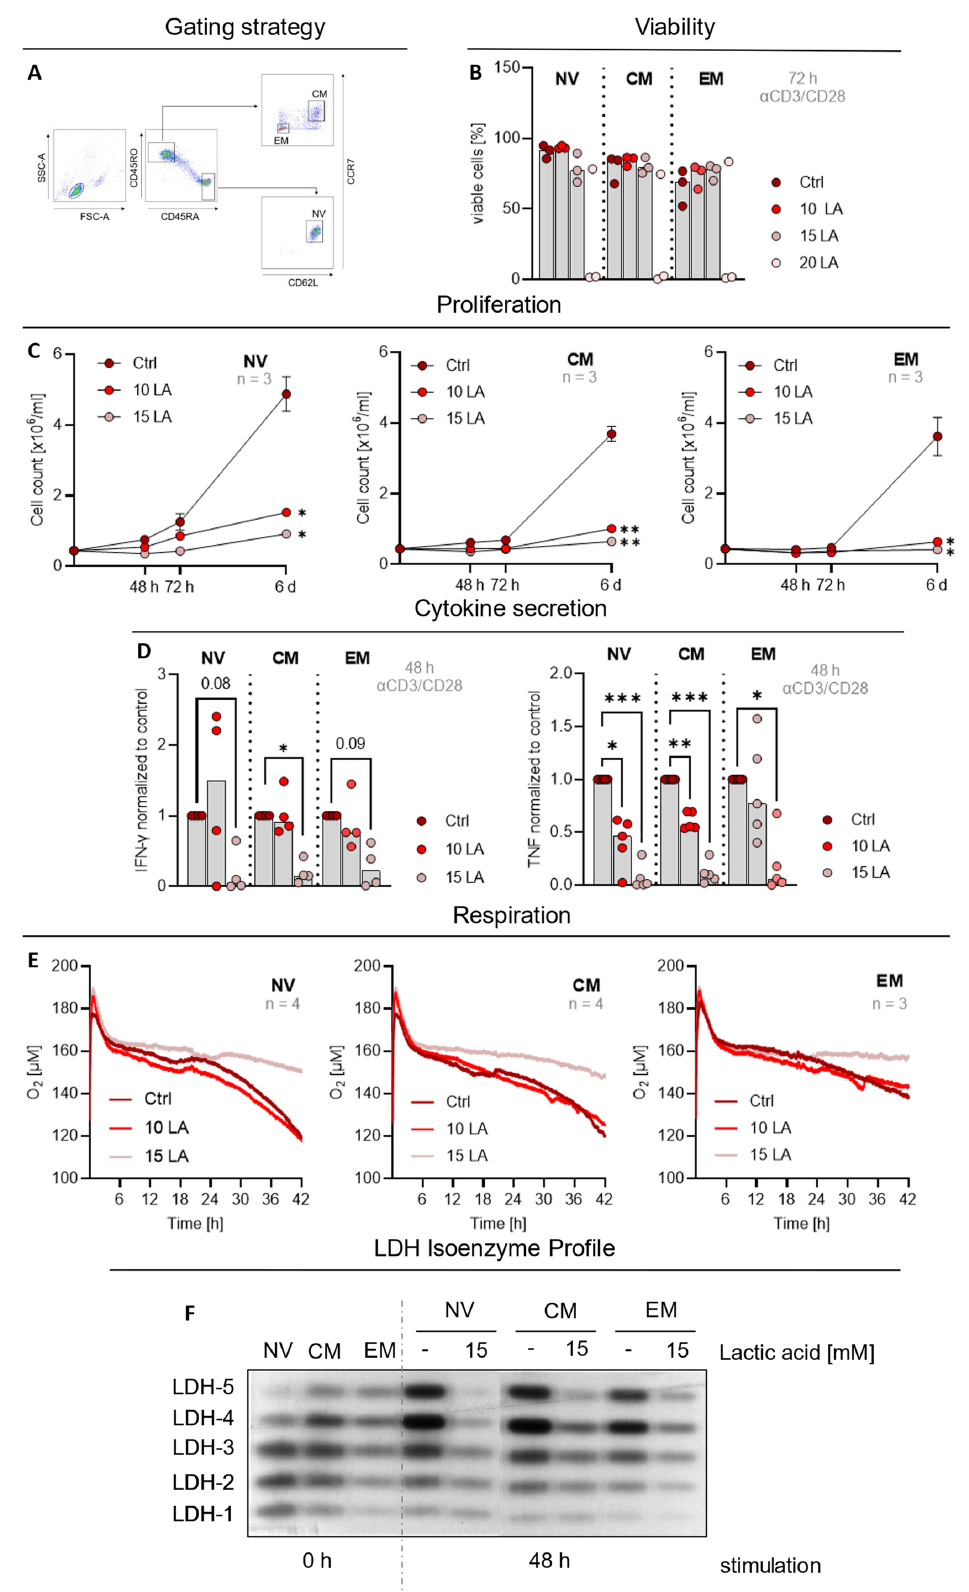
Figure 1. CD4 T cell subsets do not show inherent resistance towards lactic acid. ( A ) Representative gating strategy for cell sorting of naïve (NV), central memory (CM) and effector memory (EM) cells by flow cytometry. ( B – F ) Naïve (NV), central memory (CM), and effector memory (EM) CD4 T